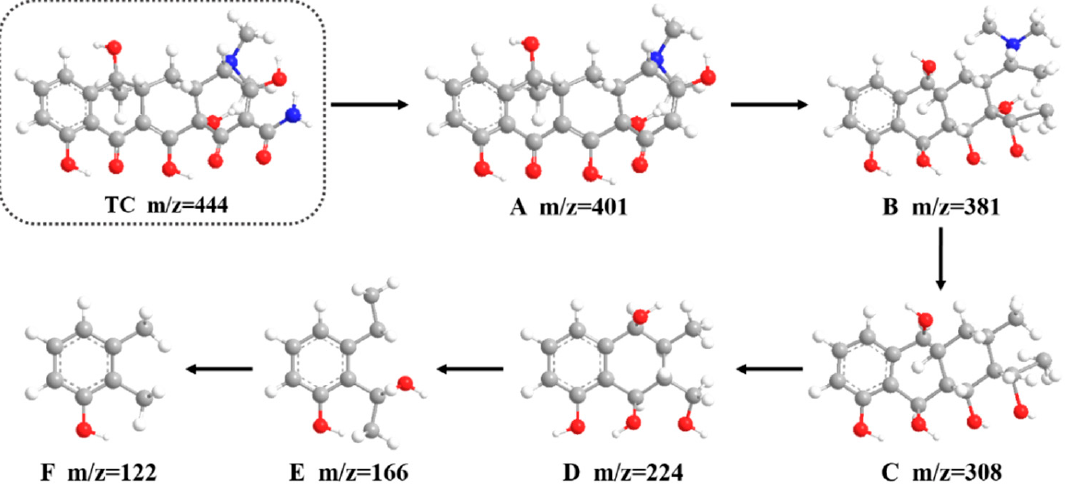
Figure 10. Proposed degradation pathway of TC.